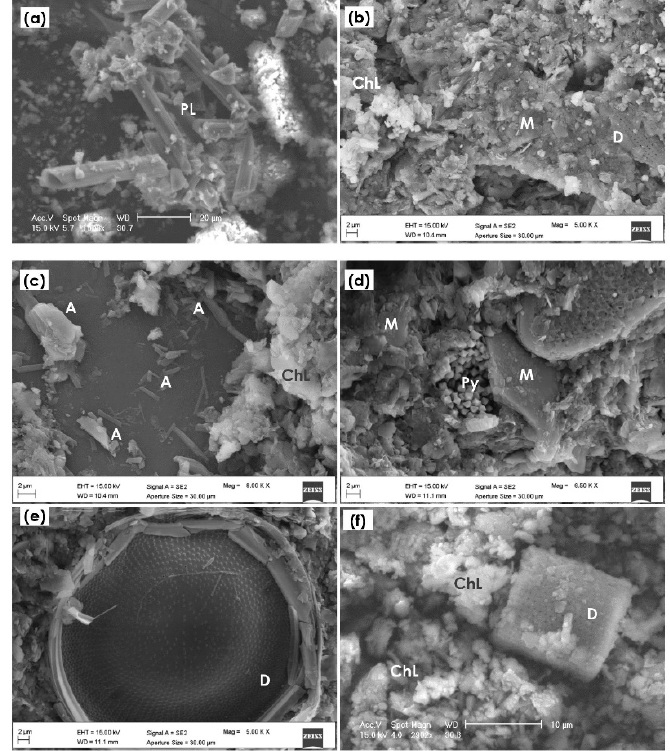
Figure 4. SEM images of the untreated soil: PL = Plagioclase ( a ), ChL = Chlorite ( b,c,f ), M = Mica ( b,d ), D = Diatoms ( b,e,f ), A = Amphibole ( c ), Py = Pyrite ( d ) .